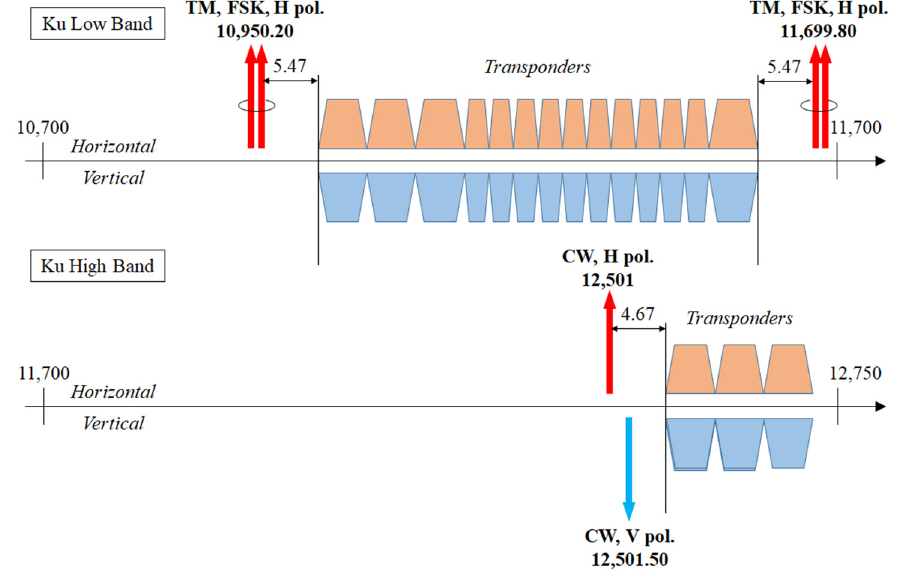
Figure 5. Simplified frequency plan (not to scale) of the Ku band geostationary satellite Eutelsat 10A, located at 10° East [44], showing polarization and frequency allocation of the beacons [45]. All the frequencies are in MHz. A single arrow indicates a CW beacon, while a double-arrow symbol represents a binary FSK-modulated TM beacon.